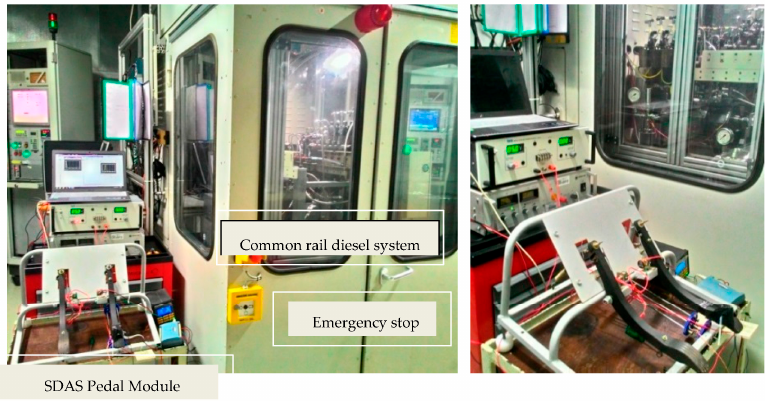
Figure 10. Photographs of the sensaptics under test run in common rail diesel system.